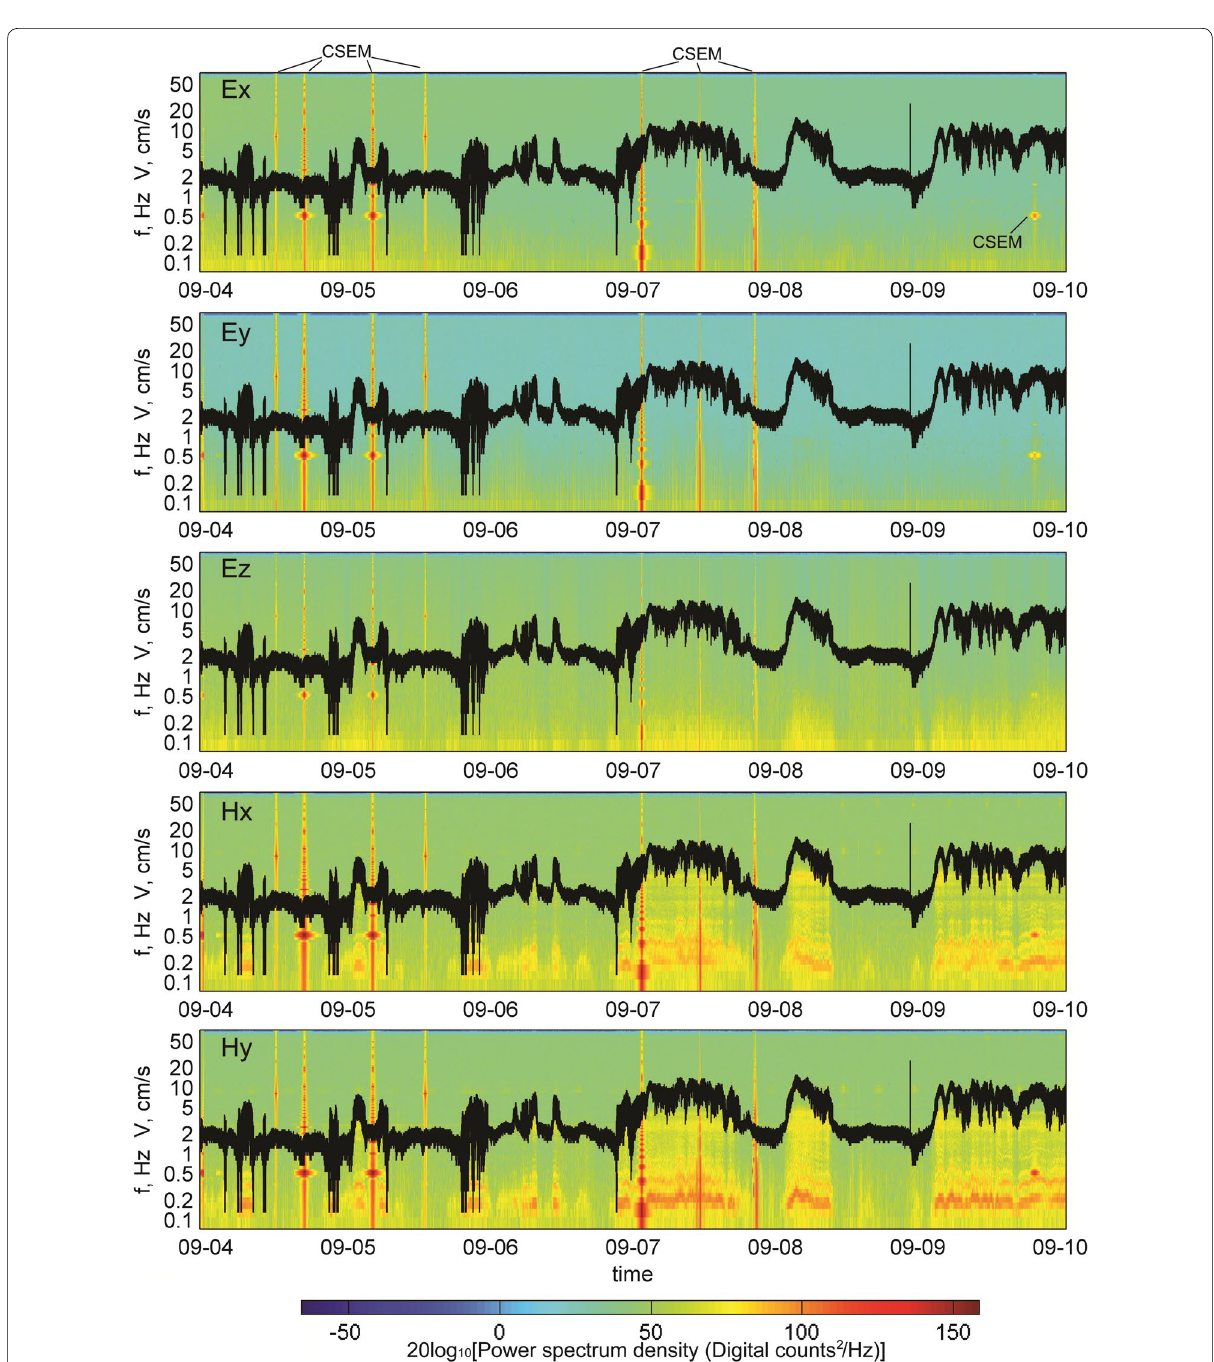
Fig. 6 Short-time fourier transform results of the five EM components and current speeds for 6 days at site QH-R10 in the Qiongdongnan area. Colors indicate the power spectrum density of the EM components. Units of the color bar are in 20log 10 (digital counts 2 per Hz). The black line indicates the current speed in